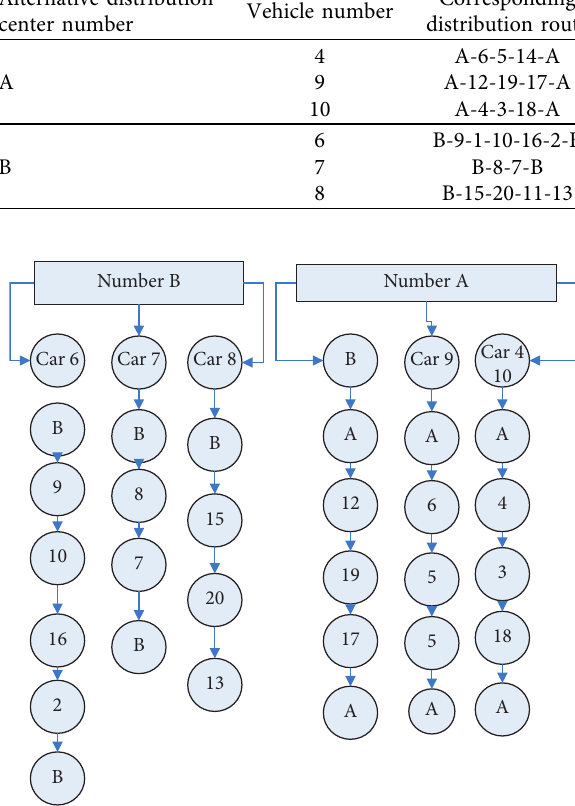
Figure 5: Location, distribution vehicles, and route